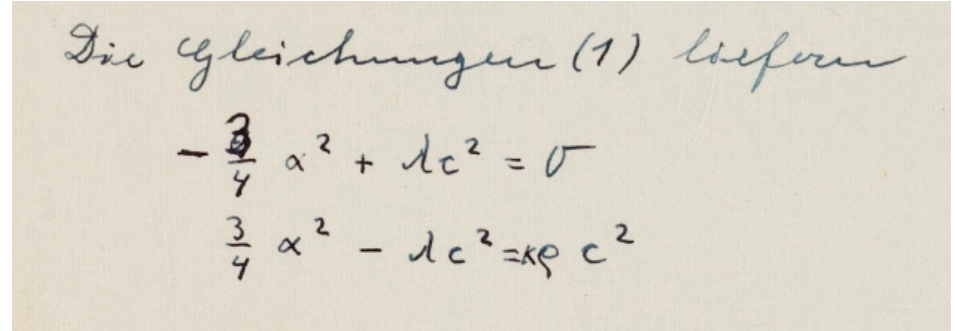
Figure 7. Einstein’s field equations as they appear in a manuscript from January 1931.